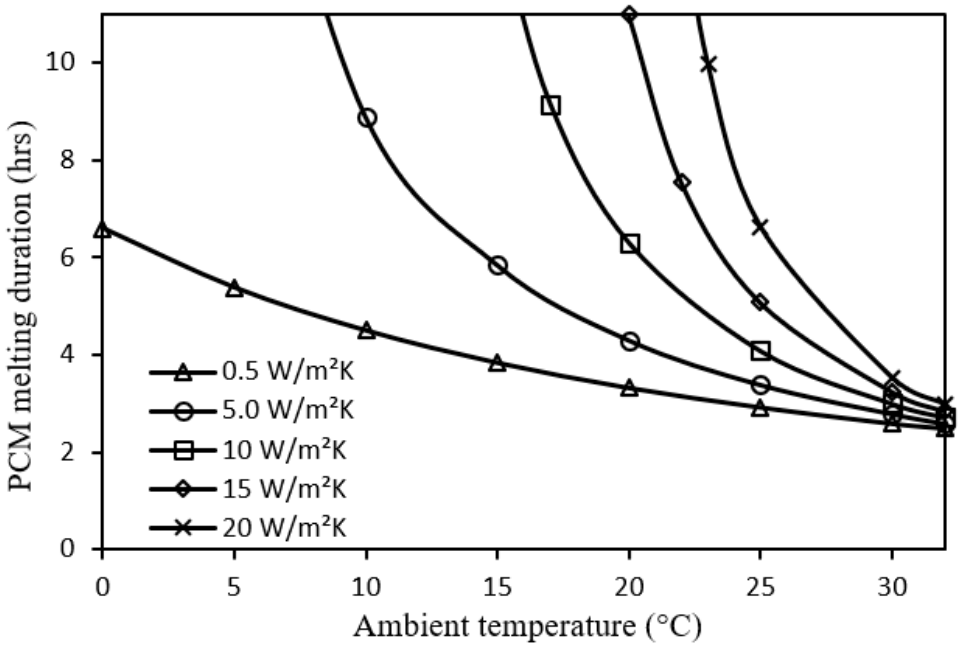
Figure 9. Impact of ambient temperature on PCM melting duration for different metal foam convec- tive heat transfer coefficients.